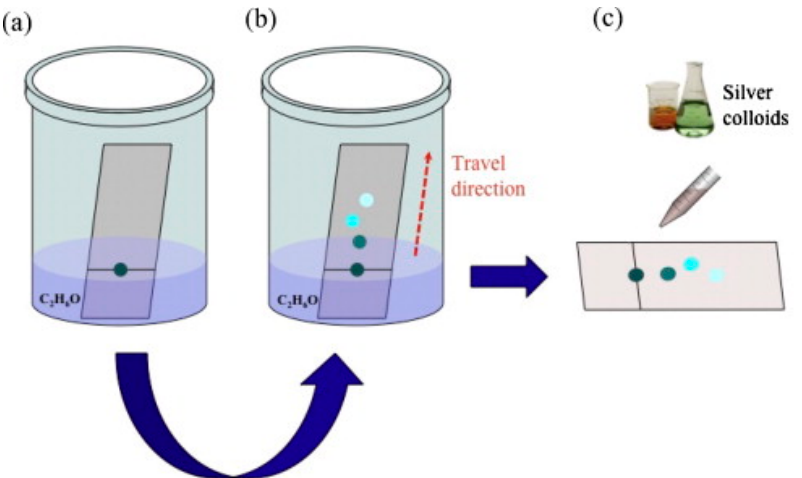
Figure 41. ( a ) A drop of plasma blood containing apomorphine is put on a thin layer chromatography (TLC) slide; ( b ) elution with ethanol; ( c ) a silver colloid solution is dropped on the spots after separation has occurred. Reproduced with permission from Lucotti et al. [432]. Crown copyright (2012), published by Elsevier B.V.